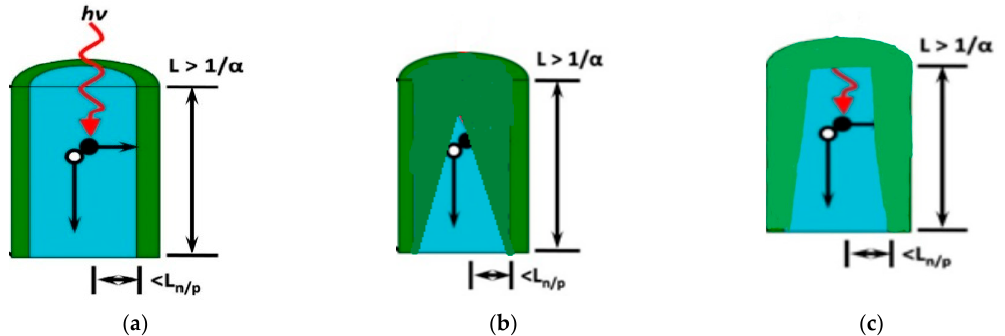
Figure 1. Image ( a ) represents the desired radial p–n junction [15], image ( b ) represents the radial p–n junction obtained when the micropillars were doped with the same method used to dope planar silicon wafers, and image ( c ) is the potential radial p–n junction with the proposed doping